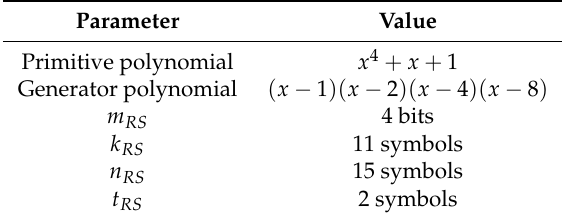
Table 2. Parameters of the studied Reed–Solomon (RS) code.